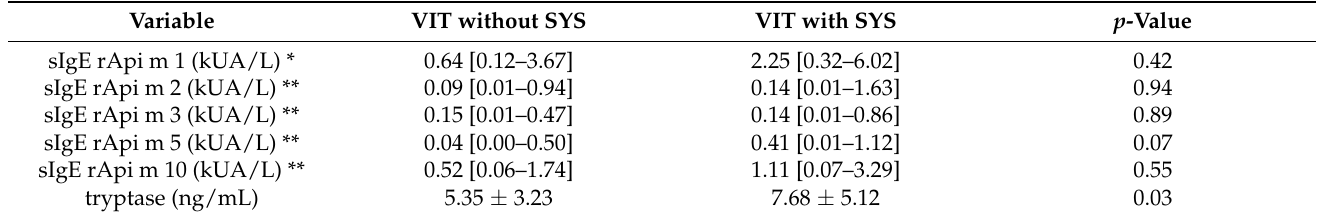
Table 7. Comparison of serum levels of specific IgE against bee venom allergen molecules and basal tryptase among patients with and without allergic side effects during the bee venom immunotherapy. Variable p